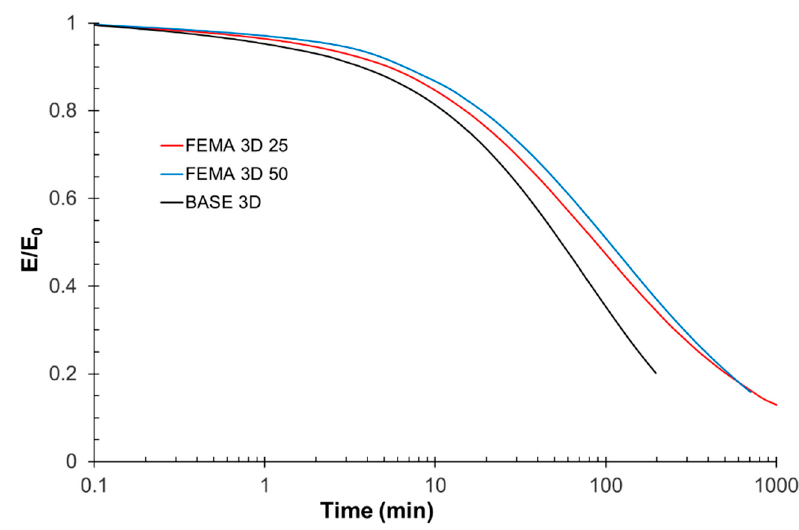
Figure 11. Stress relaxation at 180 °C of 3D printing formulations.